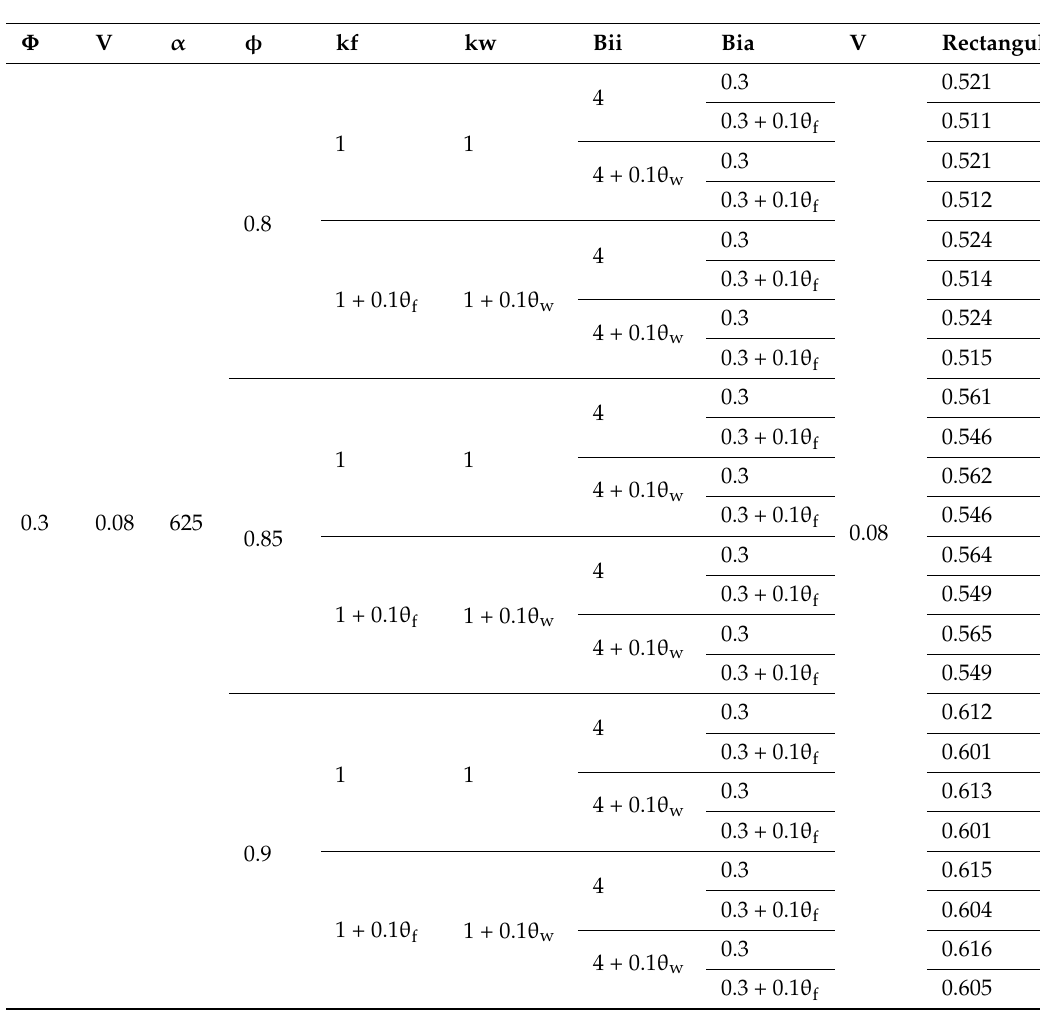
Table 2. The numerical solutions of wet-dry interface r wd for different types of fins. Various φ , k w , k f , Bi i , and Bi a .